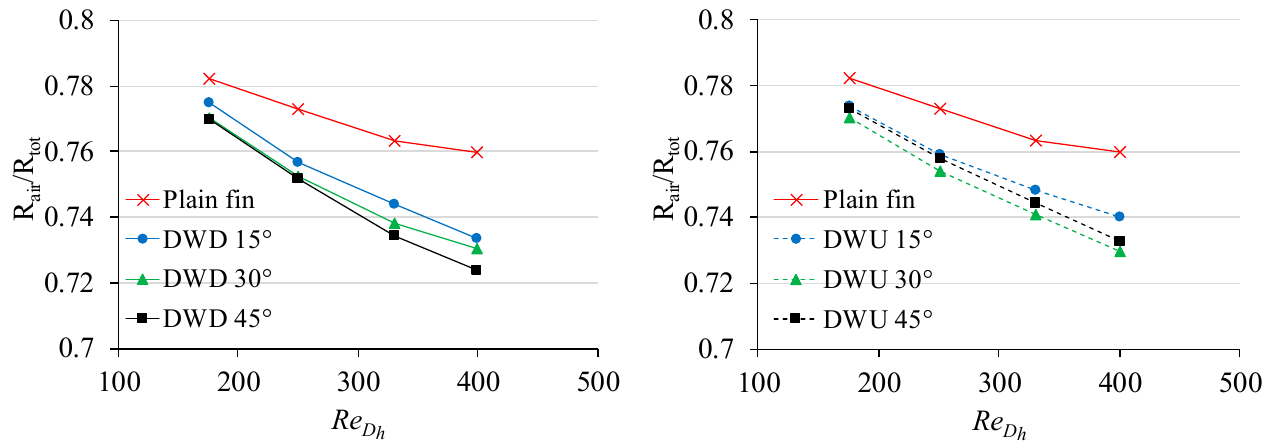
Figure 20. The effect of attack angle on the air-side thermal resistance fraction R air / R tot for air-to- water FTHEX with delta-winglet downstream (DWD, solid lines) and delta-winglet upstream (DWU, dashed lines) configurations. Test conditions: T air,in = 22 °C, T water,in = 40 °C, w water,in = 0.76 m/s.